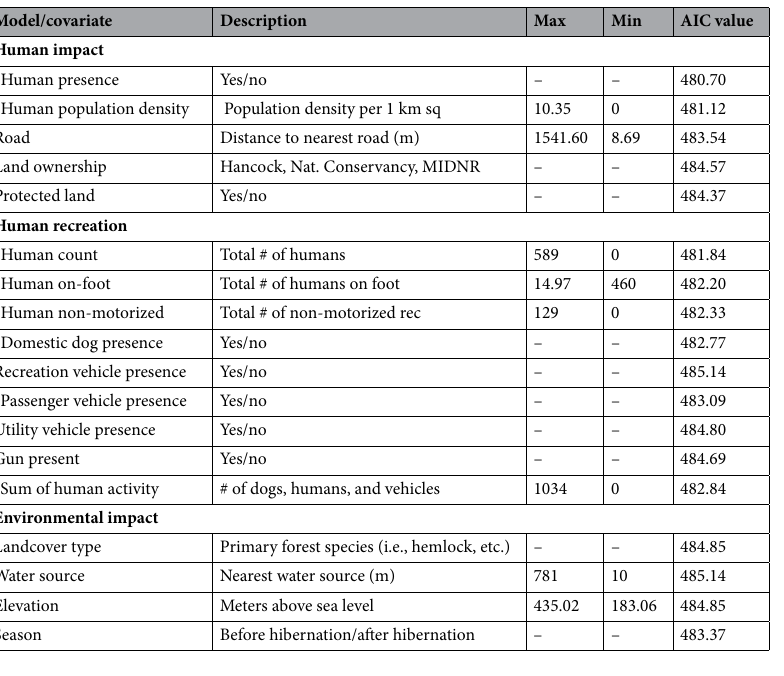
Table 1. Summary of environmental and human covariates included in occupancy models based on values for each camera site before and after hibernation. (*) Indicates significant